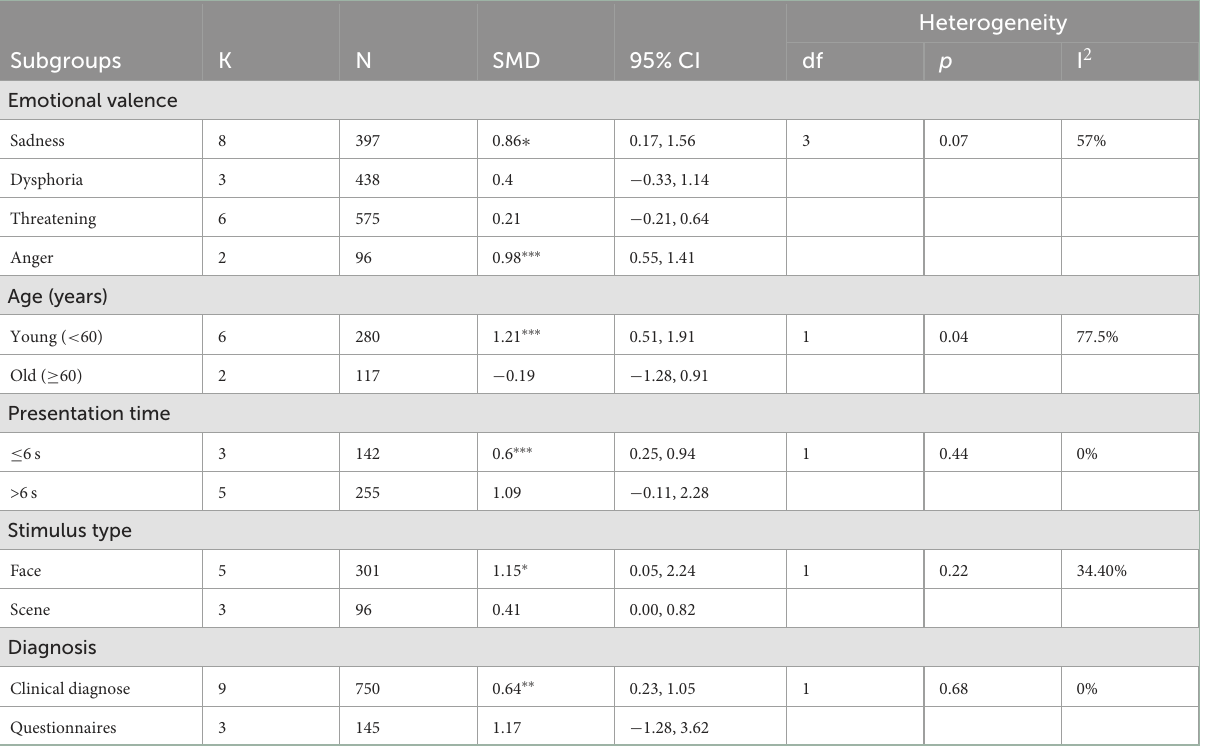
TABLE 4 Moderate effects of fixation duration on negative emotional stimuli.